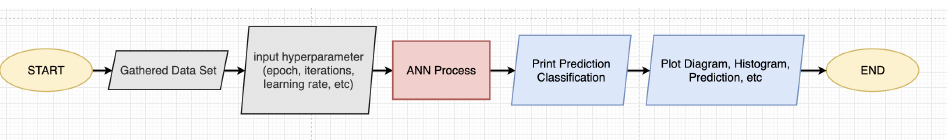
Figure 7. Detailed breakdown of the steps in PCA.